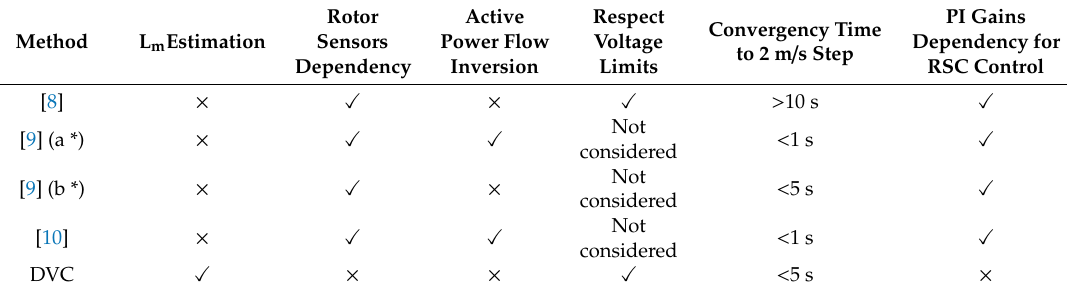
Table 3. Comparison of proposed Direct Voltage Control with other